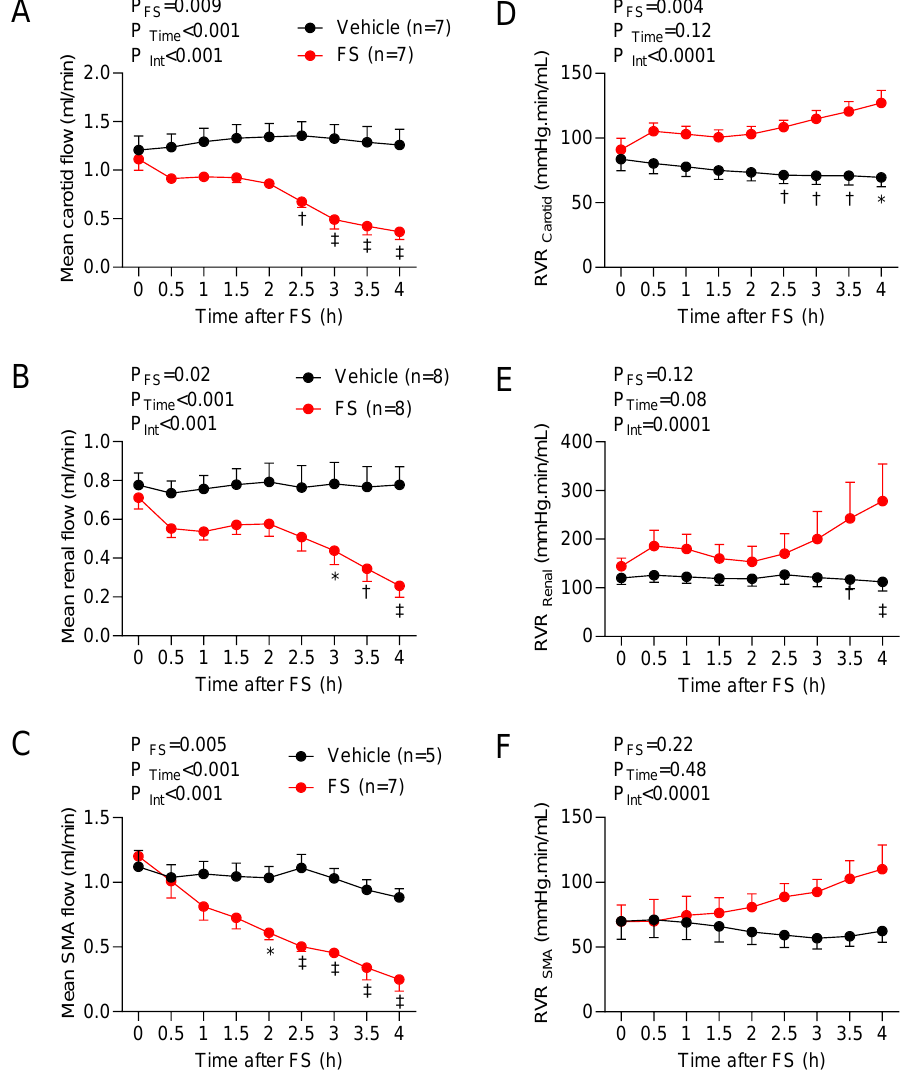
Figure 2. Fecal-slurry (FS)-induced peritonitis caused a progressive decline in mean blood flow through ( A ) the carotid artery, ( B ) the renal artery, and ( C ) the superior mesenteric artery (SMA) and a progressive increase in regional vascular resistance (RVR) of ( D ) the carotid artery, ( E ) the renal artery, and ( F ) the superior mesenteric artery (SMA). Data were analyzed by two-way ANOVA for effects of FS and time, followed by the Holm–Sidak post hoc test for multiple comparisons. * p < 0.05, † p < 0.01, and ‡ p < 0.001 compared with the vehicle at the same time.